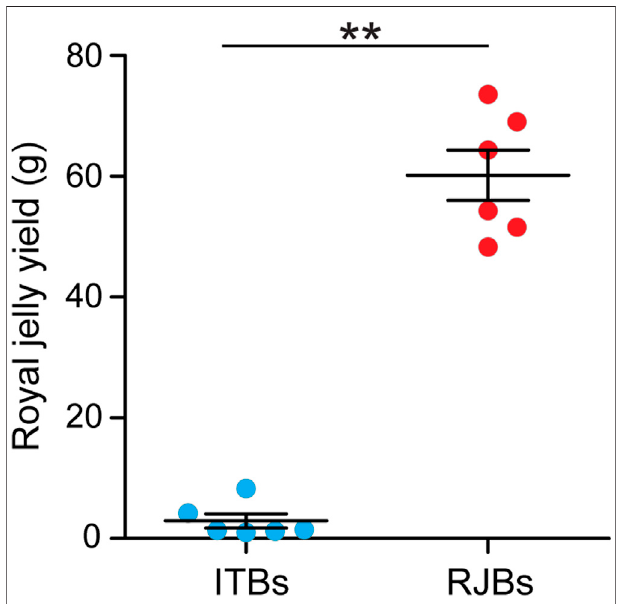
FIGURE 1 | Comparison of royal jelly yield between RJBs and ITBs. Royal jelly was collected at 72 h after grafting young worker larvae into queen cells. The data are expressed as mean ± SEM ( n = 6).